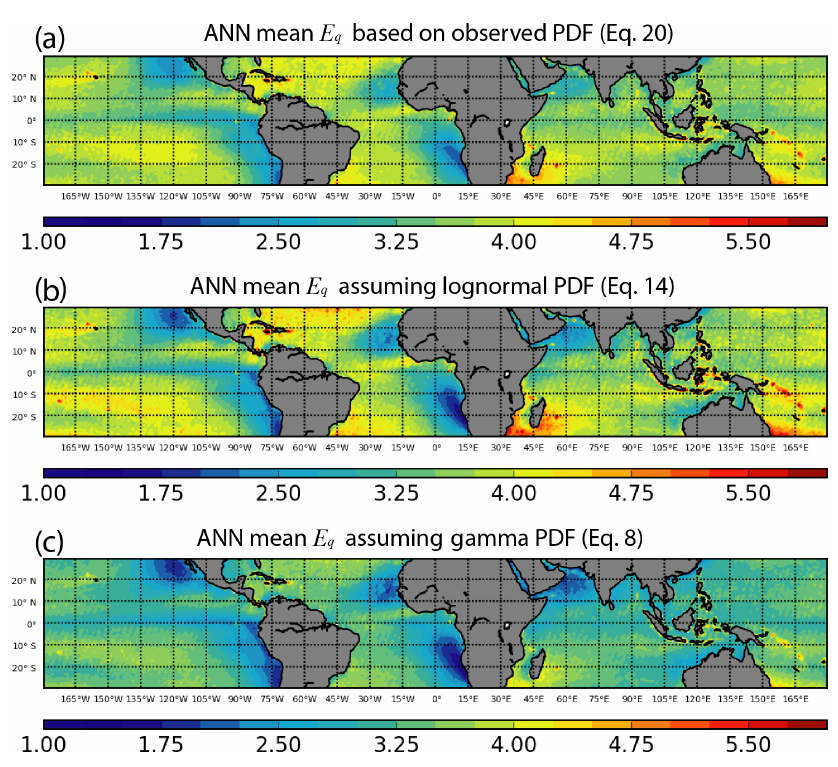
Figure 6. The annual mean factor for the KK2000 scheme due to subgrid variation of LWP computed (a) directly from observation, i.e., E q in Eq. (20), (b) from relative variance assuming lognormal PDF of LWP, i.e., E q in Eq. (14), and (c) from relative variance assuming the gamma PDF of LWP, i.e., E q in Eq.